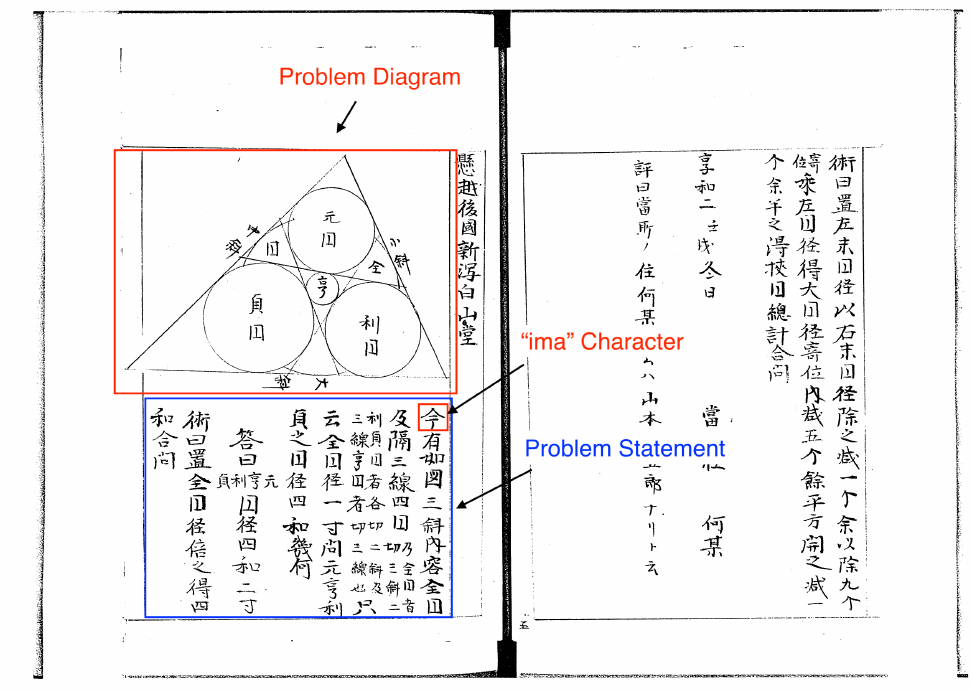
Figure 1. A Wasan page from a book in the Sakuma collection. （ 今 ） marks the start of the problem description. Typically this kanji is located either beside or under the geometric problem diagram